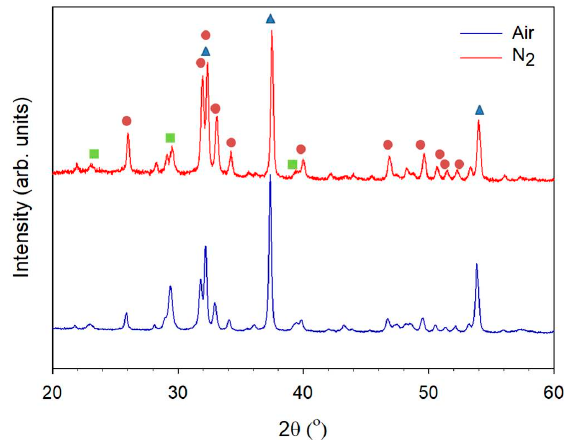
Figure 1. XRD pattern of the fibers calcined at different temperatures under an air atmosphere.